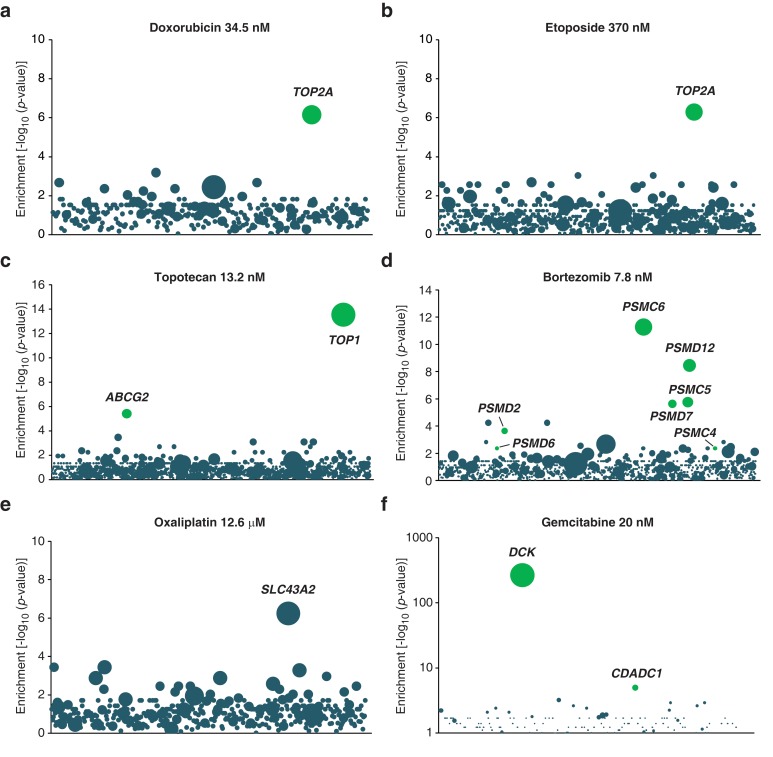
Validation of KBM7 loss-of-function screens using anticancer drugs with well-characterized mechanisms of action.(a–f) Loss-of-function genetic screens were performed and displayed as described in Figure 1a. Cells were treated with anticancer drugs at the concentration specified in each panel. Green bubbles represent genes known to be involved in the mechanism of action of the drug tested and the diameter of the bubble is proportional to the number of unique insertion sites in the pooled resistant clones (doxorubicin, TOP2A: N = 4; etoposide, TOP2A: N = 5; topotecan, TOP1: N = 10; bortezomib, PSMC6: N = 8; oxaliplatin, SLC43A2: N = 5; gemcitabine, DCK: N = 161). Genes with a total of less than 50 sequencing reads were not displayed in the bubble plots. (a) The screen with doxorubicin uncovered TOP2A, which encodes topoisomerase IIA, the direct target of doxorubicin (Tewey et al., 1984). (b) The screen with etoposide uncovered TOP2A, consistent with its known mechanism of action (Montecucco and Biamonti, 2007). (c) The screen with topotecan identified its known direct target (Pommier, 2006), type I topoisomerase (TOP1), as well as ABCG2. It is known that overexpression, not inactivation, of this transporter causes resistance to topotecan (Mao and Unadkat, 2015). In the pooled resistant clones, retroviral integration sites clustered to the beginning of the ABCG2 transcript and most were actually found upstream of the transcription start site (TSS). A topotecan-resistant clone (ABCG2GT) with a retroviral site 400 bp upstream of the TSS of ABCG2 was isolated and the expression level of ABCG2 was determined by RT-qPCR (Materials and methods). ABCG2GT displayed a △△CT of 6.2 ± 0.3 compared to KBM7 indicating an increase in ABCG2 mRNA levels of up to 70-fold compared to KBM7 (mean values of three independent experiments ± standard deviation). (d) The screen with bortezomib, a proteasome inhibitor (Adams, 2004), identified proteasome subunits (PSMC6, PSMD12, PSMC5, PSMD7, PSMD2). (e) The screen with oxaliplatin, a DNA crosslinker, identified SLC43A2, a solute carrier that transports neutral amino acids into cells (Bodoy et al., 2013), suggesting that SLC43A2 facilitates the transport of oxaliplatin into cells consistent with the known role of solute carriers in the transport of anticancer drugs (Li and Shu, 2014). (f) The screen with gemcitabine, a deoxycytidine analog, identified DCK and CDADC1. Deficiency of DCK is associated with gemcitabine resistance (Bergman et al., 2002) and CDADC1 is a cytidine and dCMP deaminase known to be involved in resistance to deoxycytidine analogs (Cai et al., 2008) (Figure 1—figure supplement 2—source data 1).DOI:
http://dx.doi.org/10.7554/eLife.14601.00710.7554/eLife.14601.008Figure 1—figure supplement 2—source data 1.Source data for anticancer drug loss-of-function KBM7 screens.